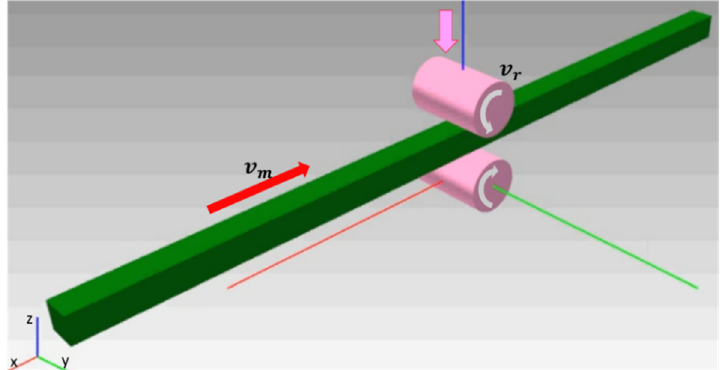
Figure 4. Robotics Lab modeling of simplified hot rolling system.